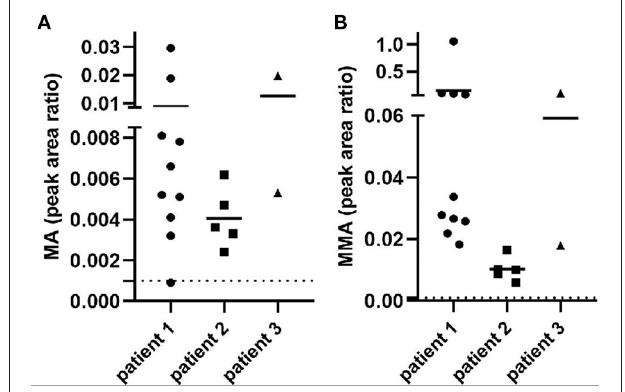
FIGURE 1 | MA and MMA excretion in urine from all the patients. The x -axis represents different patients, and the value of the y -axis means metabolite peak area ratio to creatinine (Cr). Dotted lines represent reference range. (A) Peak area ratio of MA/Cr indicated the MA excretion in patients. (B) Peak area ratio of MMA/Cr indicated the MMA excretion in